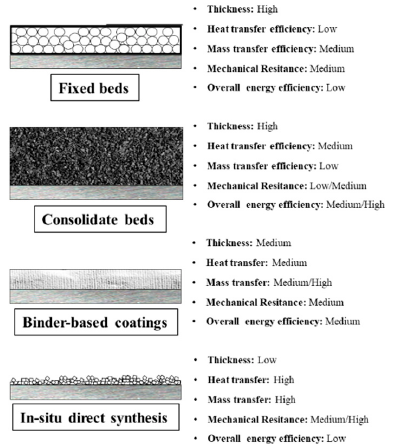
Figure 2. Comparison between characteristic properties of four Ad-HEX configurations.